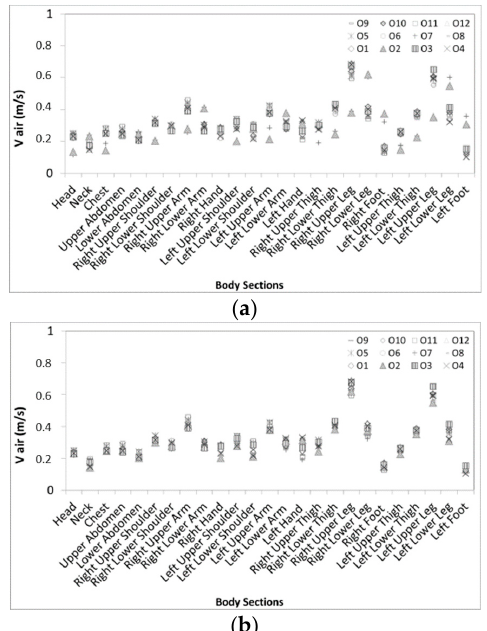
Figure 15. Mean air velocity value around the 25 human body sections of 12 occupants, for an inlet air temperature of ( a ) 20 °C and ( b ) 24 °C.